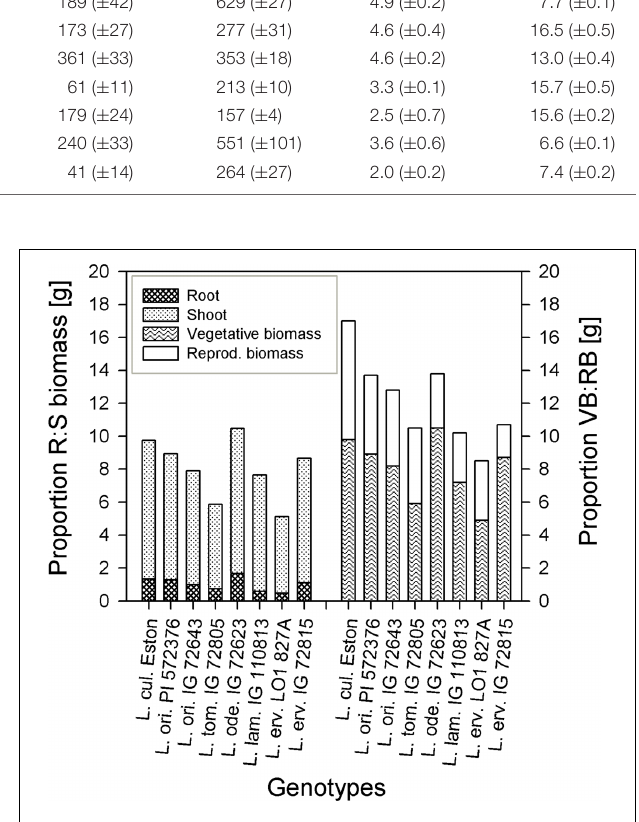
FIGURE 2 | Comparing proportions of root (R) to shoot (S) biomass and vegetative biomass (VB) to reproductive biomass (RB) in five wild lentil species to Lens culinaris